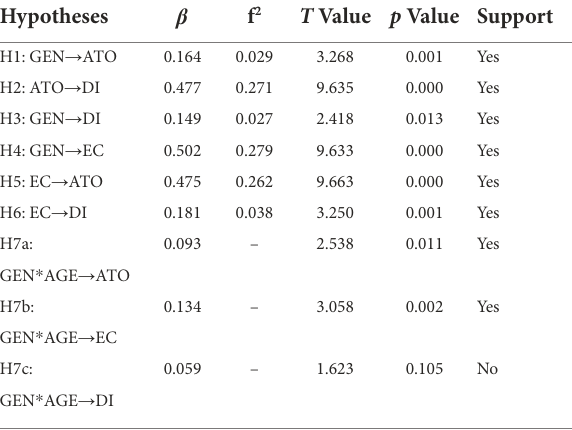
TABLE 6 Direct path for the structural